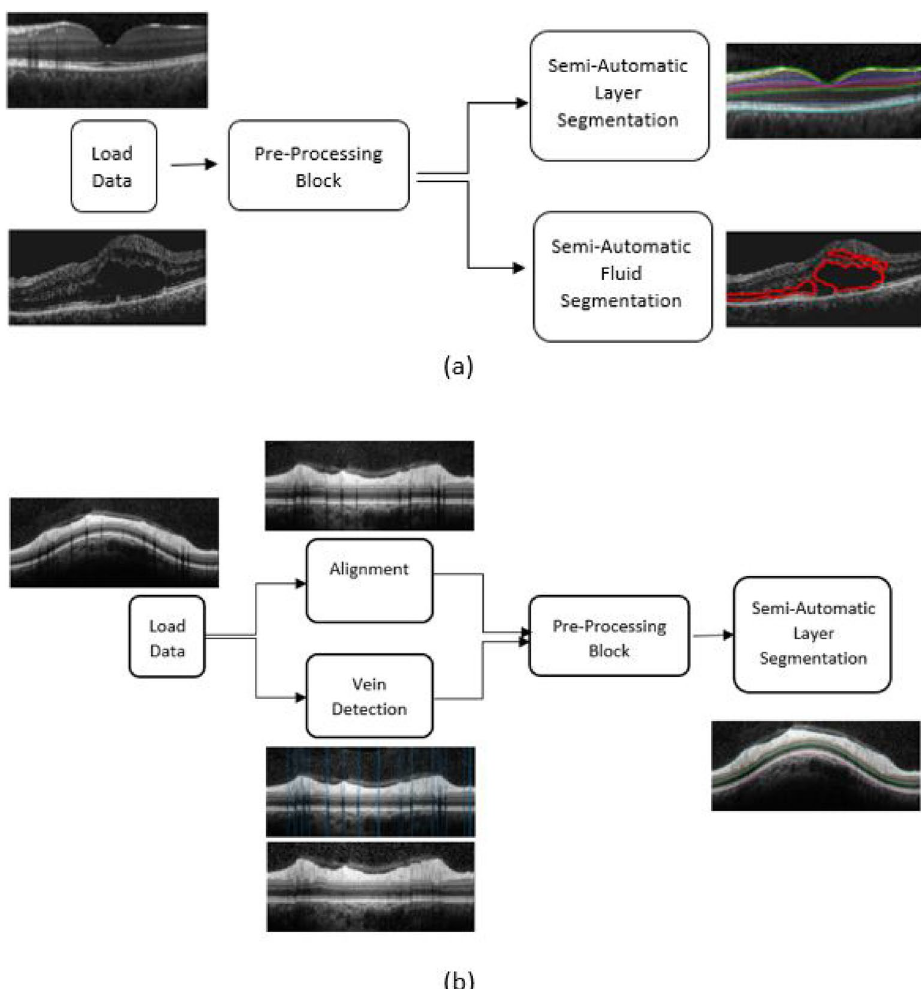
Figure 2. Livelayer software’s scheme ( a ) Macular layer and fluid segmentation sections—after loading a proper data set, the software’s pre-processing block finds an appropriate background image on which the Livelayer could be applied and then, outputs the segmented image. ( b ) Peripapillary layer segmentation section— after loading a proper peripapillary data, the software aligns the B-Scan and then, tries to omit its blood vessels as much as possible. An appropriate background image for applying the Livelayer is detected and the corresponding segmented B-Scan is